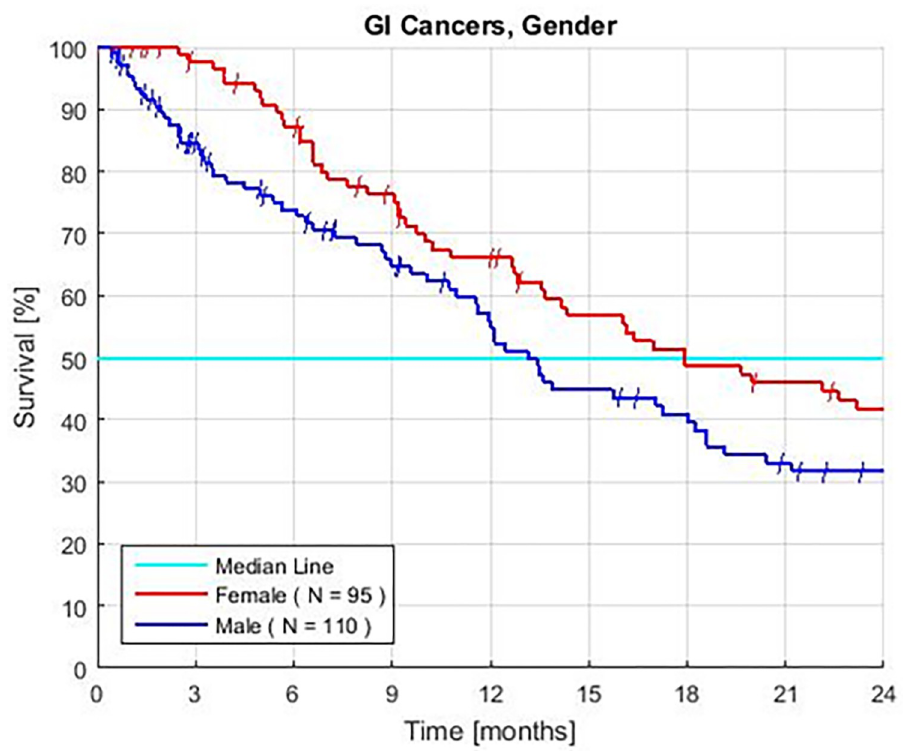
Fig 4. Female vs. Male Kaplan—Meier survival of patients with advanced gastrointestinal cancers treated with GFLIO. The overall P value = 0.05. The P value most strongly favors females with advanced pancreatic cancers.